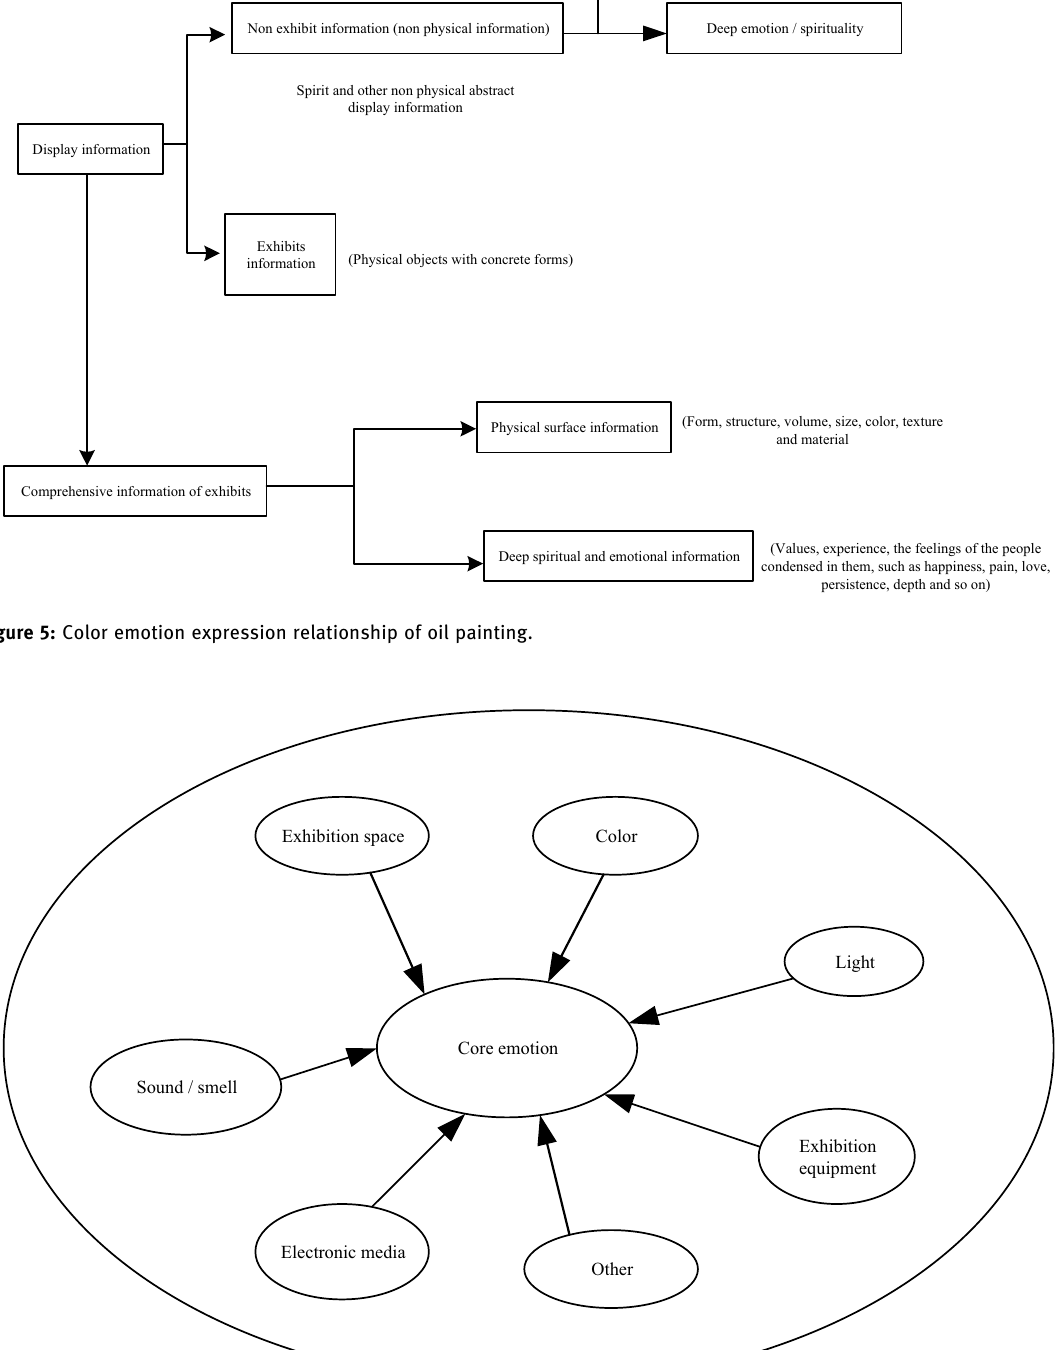
Figure 6: Connotation of emotional information transmission of oil painting